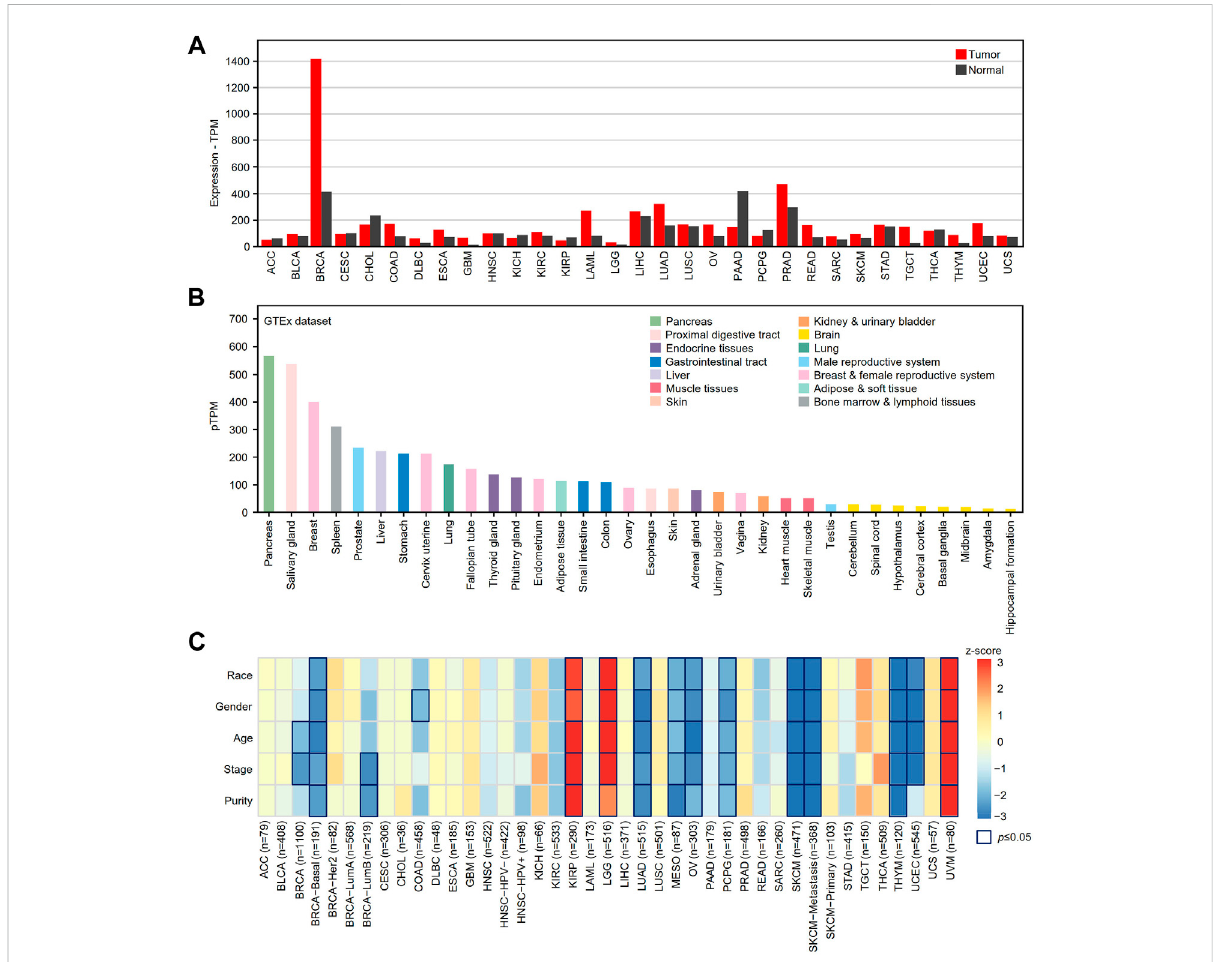
FIGURE 1 ThemRNAexpressionanalysisofXBP1invarioushumancancertissues. (A) XBP1expressionindifferenthumancancersampleswasdetermined by GEPIA2 in comparison with adjacent peritumor samples. (B) The expression pro fi les of XBP1 in healthy human tissues in HPA. Color-coding is based on tissue groups, each consisting of tissues with functional features in common. (C) The survival correlation of XBP1 expression adjusted by different clinical factors in the TIMER2.0 database. The result of p ≤ 0.05 is signi fi cant. Abbreviation: ACC, adrenocortical carcinoma; BLCA, bladder urothelial carcinoma; BRCA, breast invasive carcinoma; CESC, cervical squamous cell carcinoma (include endocervical adenocarcinoma); CHOL, cholangio carcinoma; COAD, colon adenocarcinoma; DLBC, lymphoid neoplasm diffuse large B-cell lymphoma; ESCA, esophageal carcinoma; GBM, glioblastoma multiforme; HNSC, head and neck squamous cell carcinoma; KICH, kidney chromophobe; KIRC, kidney renal clear cell carcinoma; KIRP, kidney renal papillarycell carcinoma; LAML,acute myeloid leukemia; LGG,brain lowergrade glioma;LIHC, liverhepatocellular carcinoma; LUAD, lung adenocarcinoma; LUSC, lung squamous cell carcinoma; MESO, mesothelioma; OV, ovarian serous cystadenocarcinoma; PAAD, pancreatic adenocarcinoma; PCPG, pheochromocytoma and paraganglioma; PRAD, prostate adenocarcinoma; READ, rectum adenocarcinoma; SARC, sarcoma; SKCM, skin cutaneous melanoma; STAD, stomach adenocarcinoma; TGCT, testicular germ cell tumors; THCA, thyroid carcinoma; THYM, thymoma; UCEC, uterine corpus endometrial carcinoma; UCS, uterine carcinosarcoma; UVM, uveal